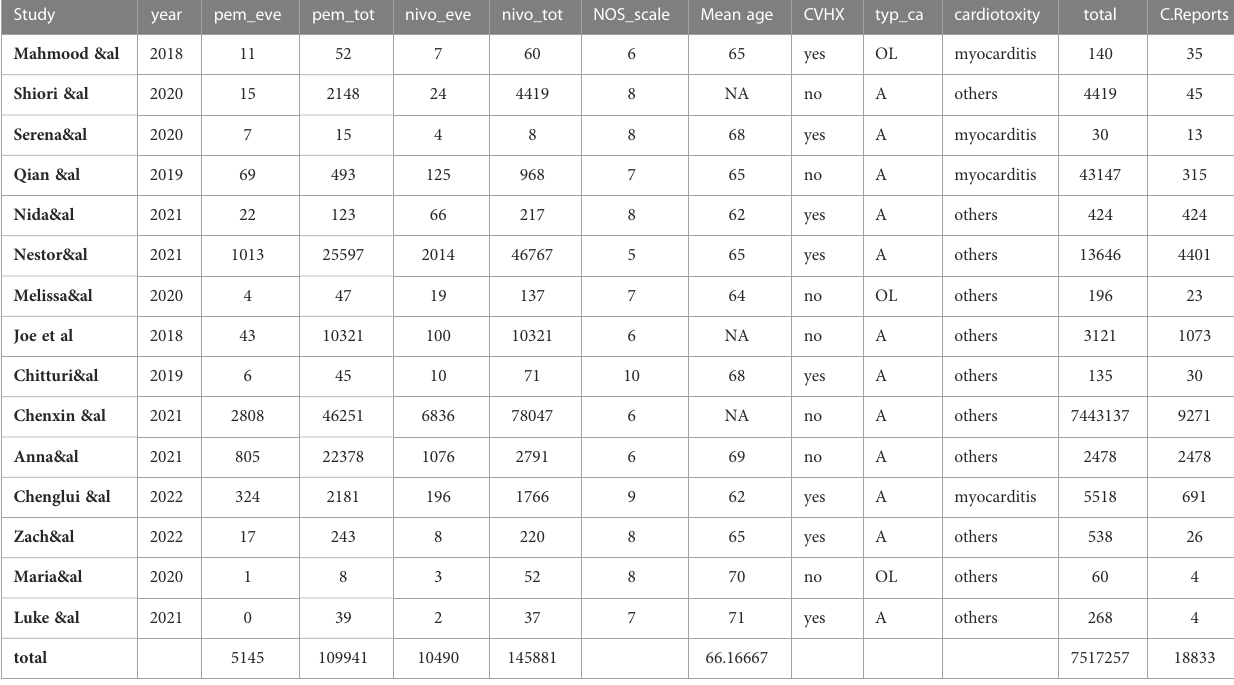
TABLE 1 Characteristic of included studies.